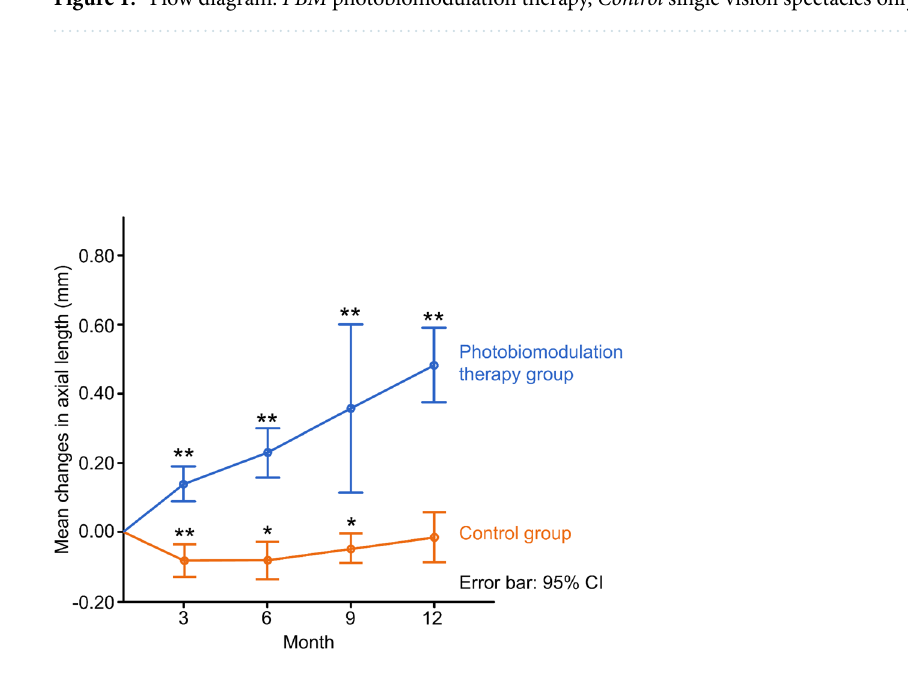
Figure 2. Changes of axial length of two groups at 3-, 6-, 9-, 12-month follow-up, respectively. ** and *represent P < 0.001 and P < 0.01 comparing the data of each follow-up with that of no change from